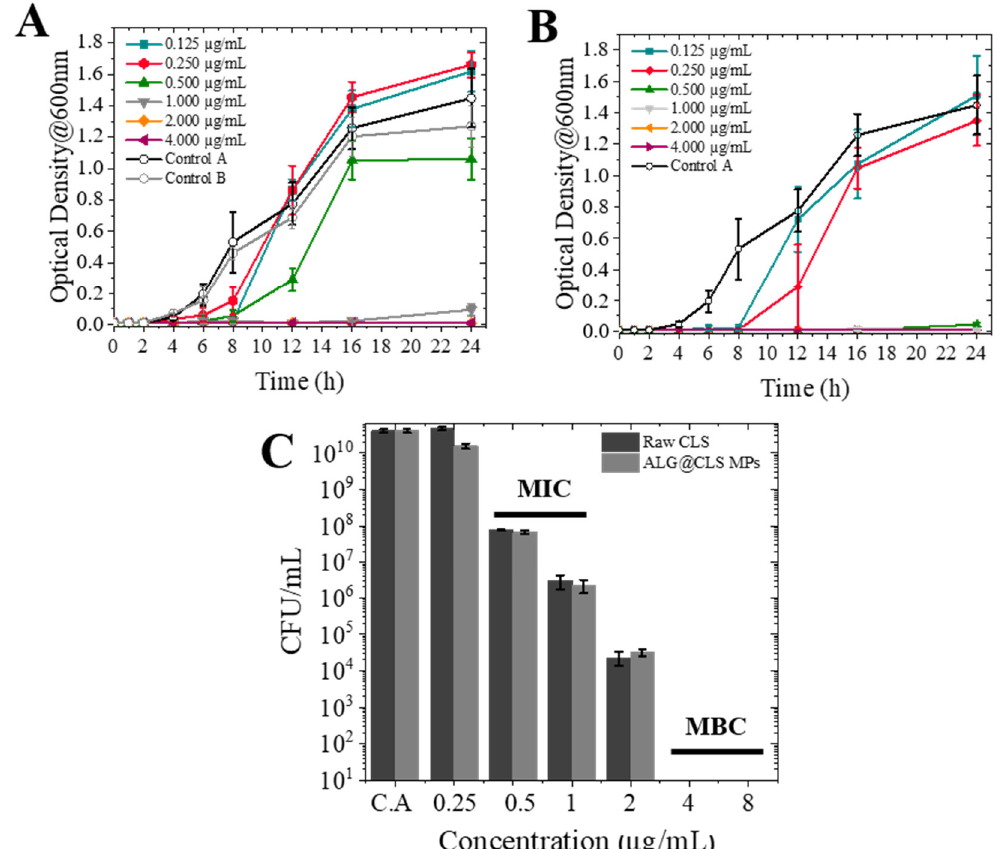
Figure 7. Antibacterial activity of colistin sulfate against P. aeruginosa . OD600 versus total concentration of ( A ) Raw colistin sulfate; ( B ) Colistin sulfate encapsulated in ALG@CLS MPs (control A was bacteria untreated and control B was bacteria in contact with water); ( C ) CFU/mL of P. aeruginosa (mean ± SD, n = 3; p < 0.05). The concentrations (µg/mL) refer to the amount of CLS, either free or encapsulated in the ALG MPs.